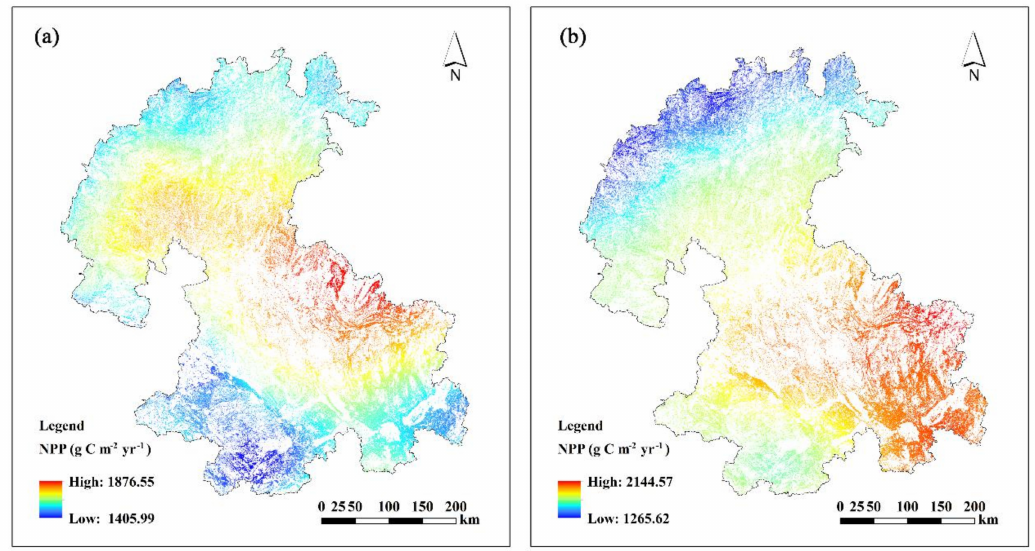
Figure 3. ( a ) NPP of cultivated land in 2000; and, ( b ) NPP of cultivated land in